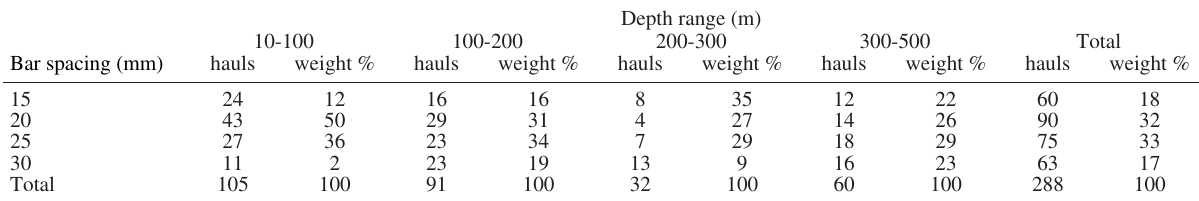
Table 2. – Number of valid hauls and weight percentage by grid (bar spacing) and bathymetric